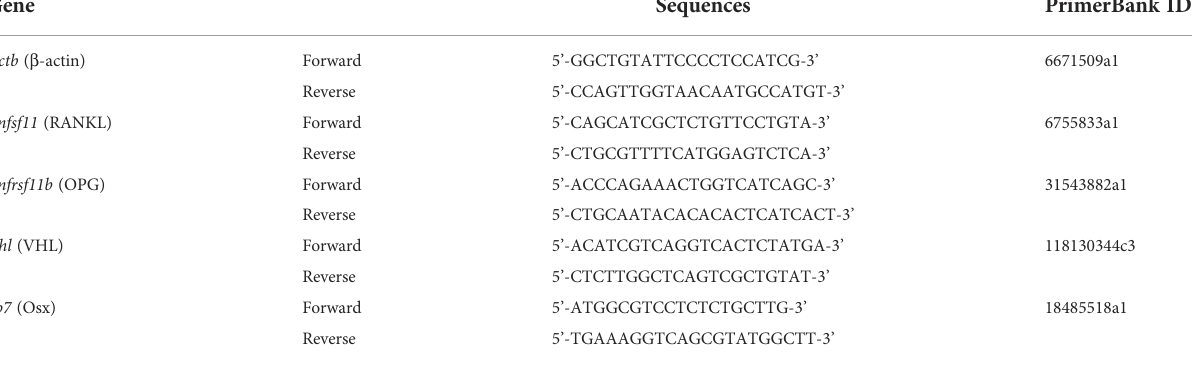
TABLE 1 Primer sequences used for